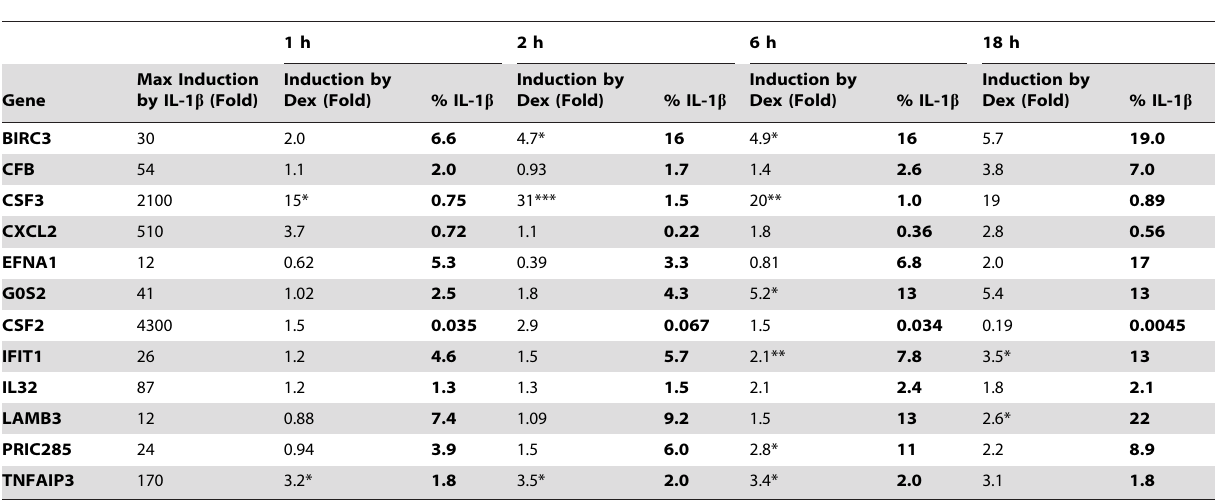
Table 1. Effect of dexamethasone treatment alone on inflammatory mRNA expression.